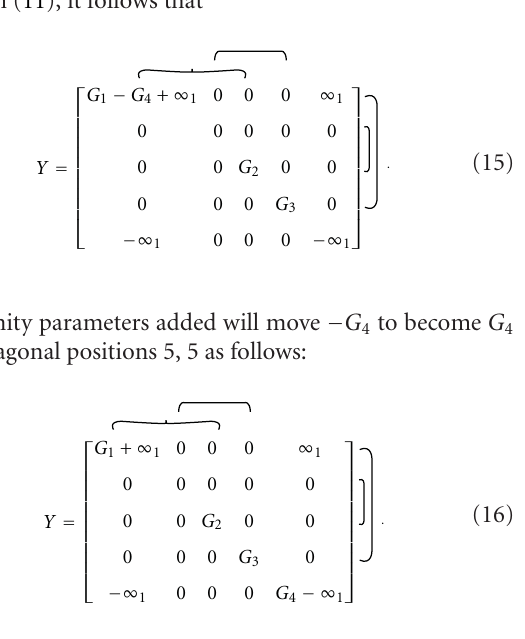
Figure 3: (a) Realization I of Class-I oscillator. (b) Realization II of Class-I oscillator, (c) Realization III of Class-I oscillator.